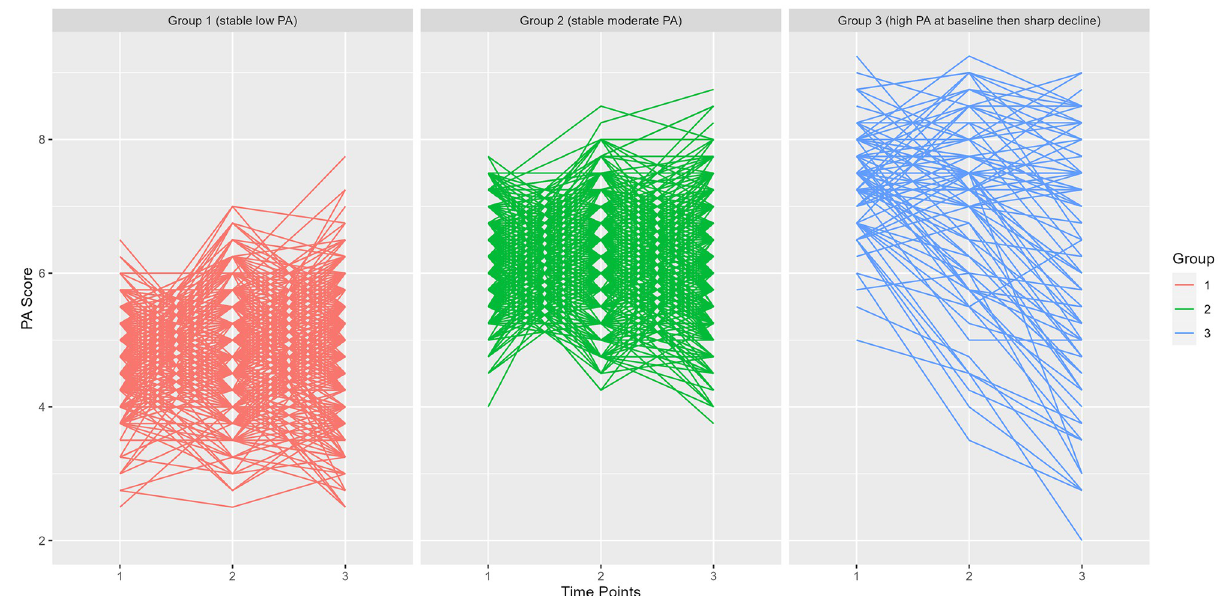
Fig 2. Regression lines of the participants in each trajectory based on the Physical Activity (PA) measurements of 1041 CARLA participants at 3 time points.